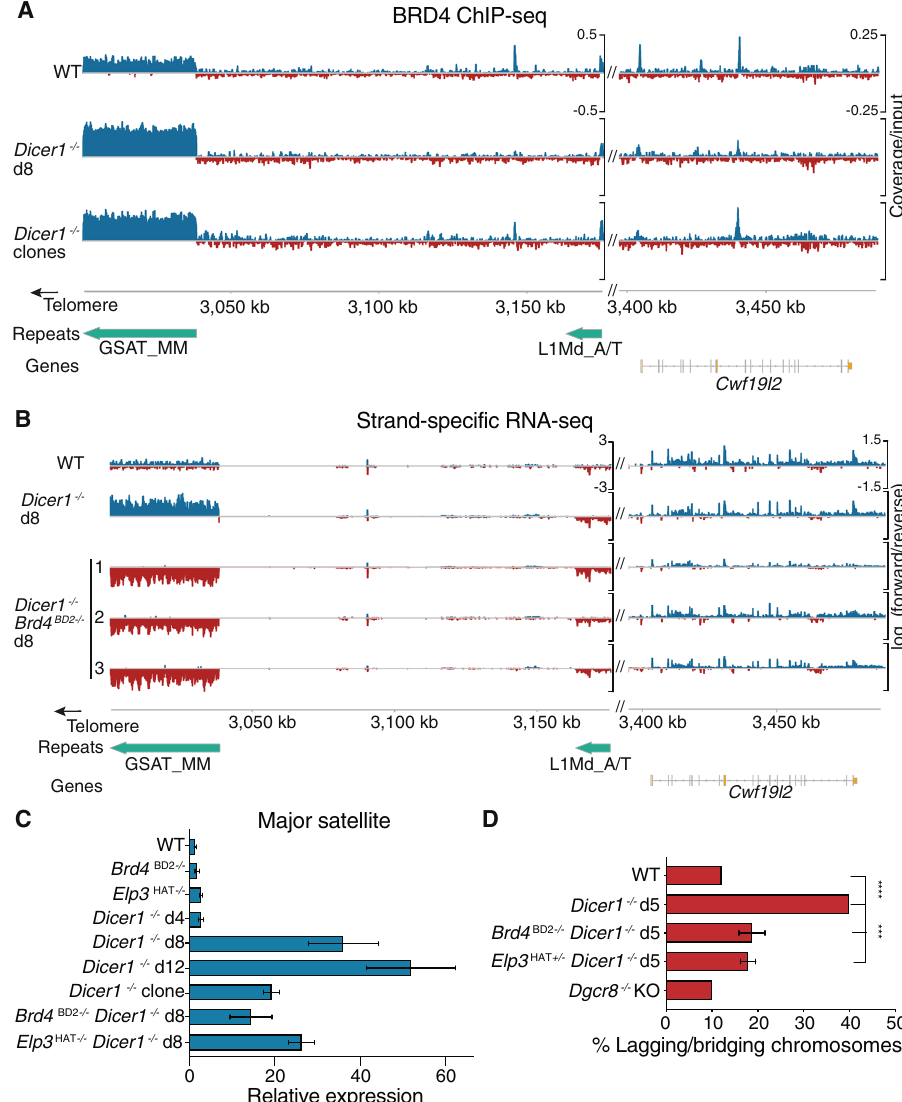
Fig. 4 BRD4 drives expression of satellite sequences in Dicer1 − / − mESCs and suppressors reduce chromosome defects. A BRD4 ChIP-seq coverage normalized to input plotted over the same major satellite repeat region at the end of chromosome 9 as in Fig. 1. BRD4 is enriched over the satellite repeat 8 days after deletion of Dicer1 ( Dicer1 − / − d8) and in viable Dicer1 − / − clones. B Strand-speci fi c transcriptional upregulation of the major satellite repeat (GSAT_MM) on chr9 is reversed in Dicer1 − / − Brd4 BD2 − / − cells. The log 2 normalized ratio of forward (blue) and reverse (red) strand is plotted. One representative replicate is plotted for WT and Dicer1 − / − cells 8 days after Dicer 1 deletion (d8). 3 independent Dicer1 − / − cultures have reversed transcription at the major satellite after Brd4 mutation in the BD2 domain, 8 days after Dicer 1 deletion. The WT and Dicer1 − / − d8 cultures are the same replicates from Fig. 1. C RT-qPCR con fi rms a strong accumulation in Dicer1 − / − mESCs of transcripts from the major satellite, which is reduced in Brd4 BD2 − / − or Elp3 HAT + / − doubles or Dicer1 − / − clones. Fold change was calculated relative to Actb and uninduced wild type controls. N = 3 independent biological experiments ( N = 2 for Elp3), error bars represent SEM. Source Data are provided in the Source Data fi le. D Chromosomal defects are reduced in Dicer1 − / − mESCs with Brd4 BD2 − / − or Elp3 HAT + / − mutations. The WT, Dicer1 − / − d5, and Dgcr8 − / − data is reproduced for comparison with Fig. 1B ( n = 100, **** − p -value < 0.0001, *** − p -value between 0.0001 and 0.001, Fisher ’ s exact test,